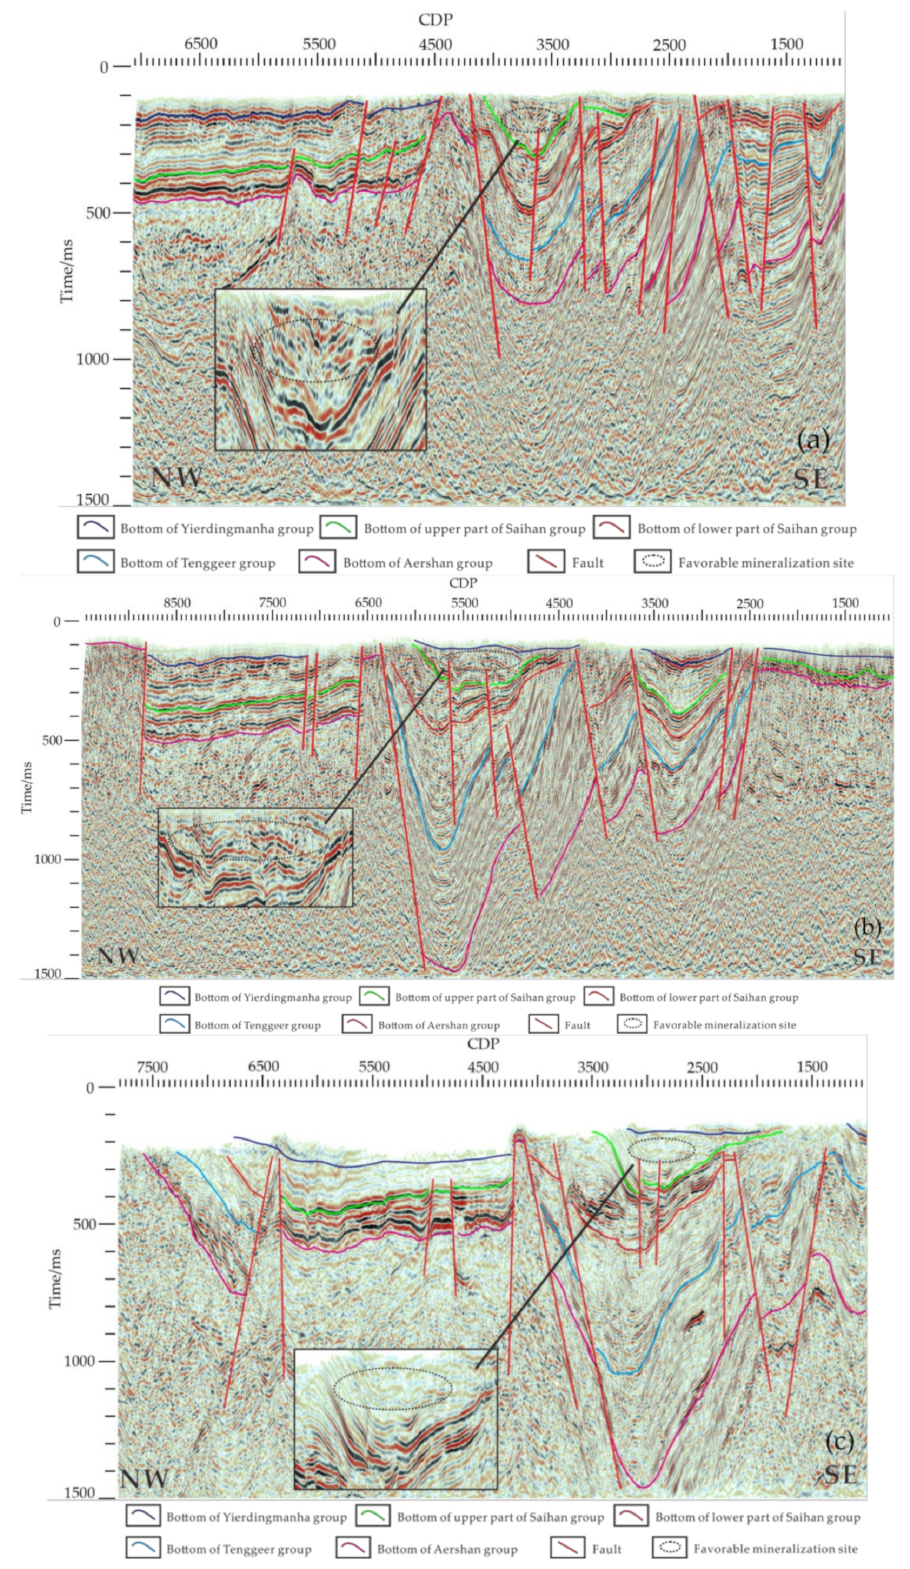
Figure 7. The seismic survey results for the Bayanwula uranium deposits: L1 ( a ), L2 ( b ), L3 ( c